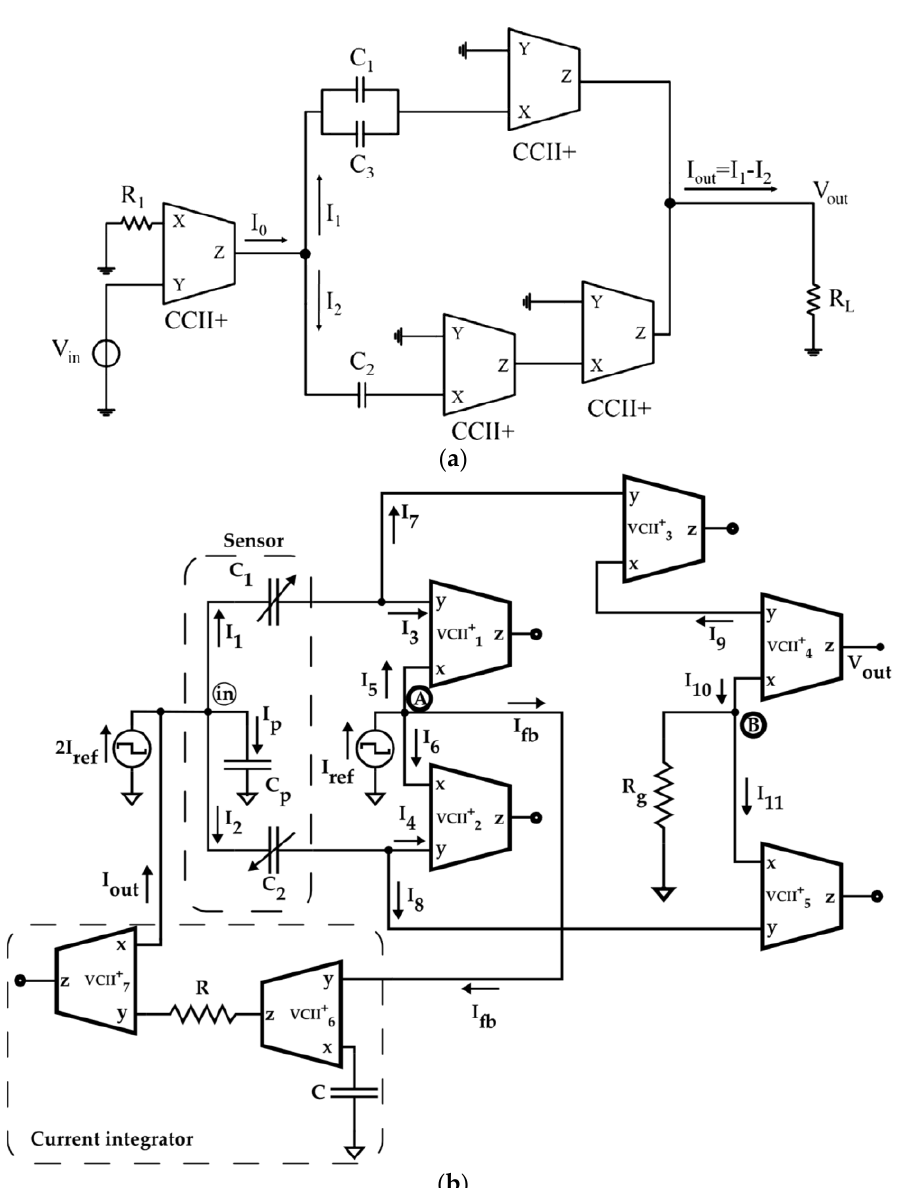
Figure 11. Two different current-mode interfaces for differential capacitive sensors: ( a ) is the CCII- based circuit proposed in [51]; ( b ) is the VCII-based circuit proposed in [52].